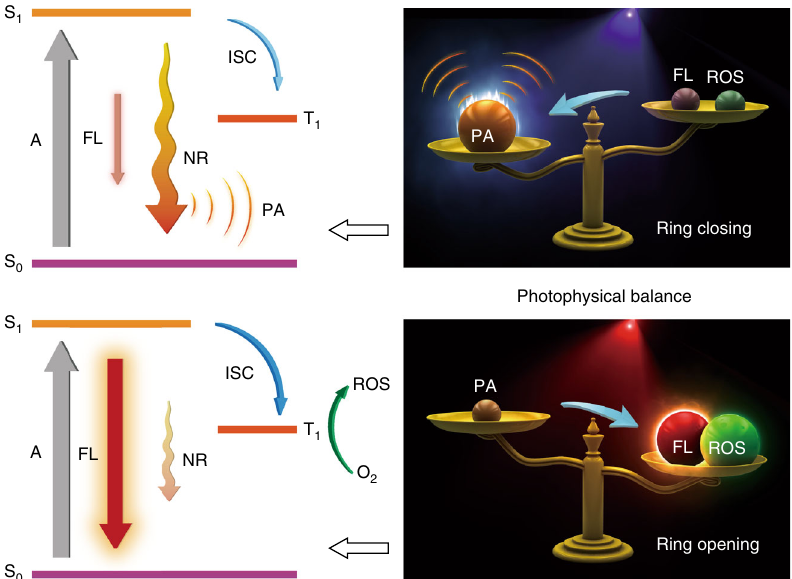
Fig. 2 Illustration of the controllable photophysical processes. The energy balance of photophysics profoundly tilts to either side controlled by external UV/ visible light exposure. A: absorption, FL: fl uorescence, NR: non-radiation, ISC: intersystem